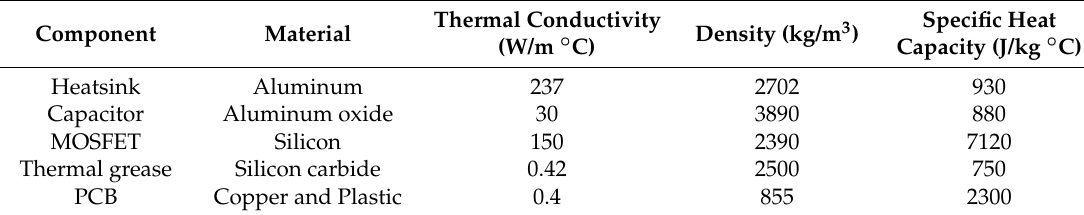
Figure 5. The electric circuit diagram of the 36V electronic control unit (ECU) system. Table 2. Specifications of the electronic control unit (ECU)